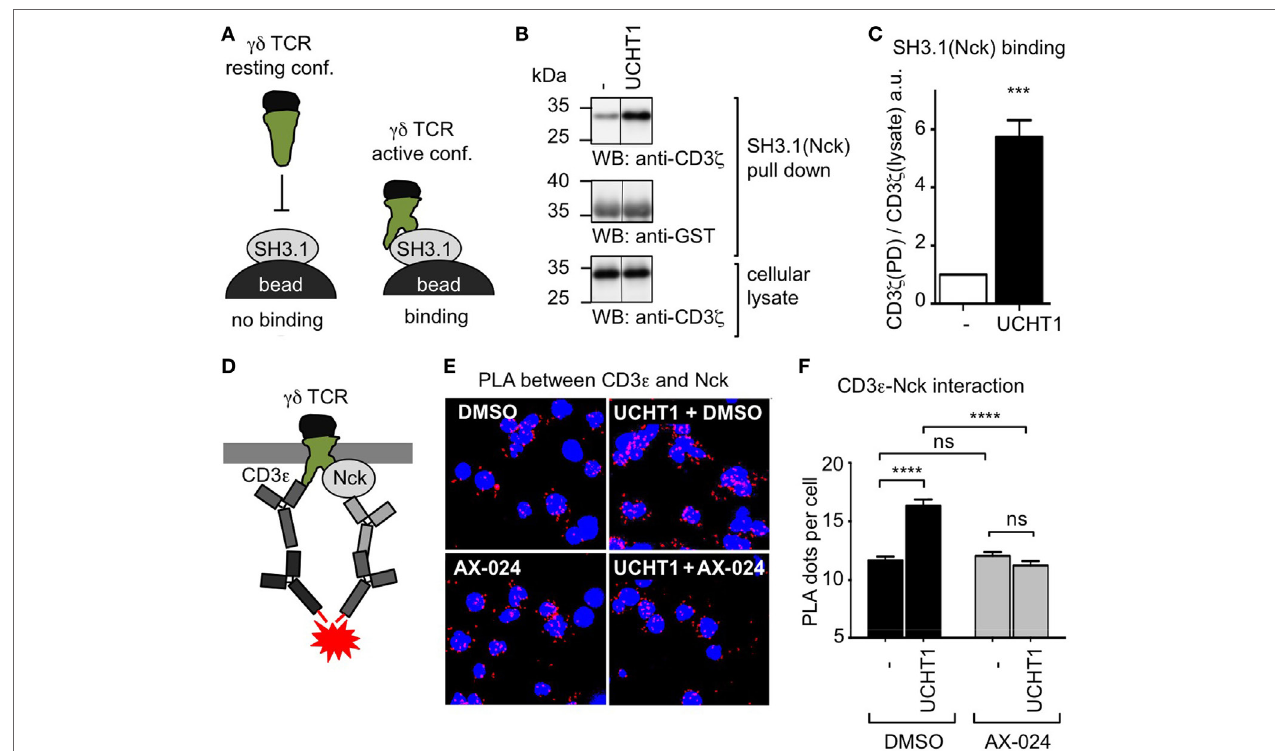
FigUre 2 | Using its SH3.1(Nck) domain Nck binds to the UCHT1-stimulated γδ T cell antigen receptor (TCR). (a) Schematic of the SH3.1(Nck) pull down assay. (B) Zoledronate-expanded γδ T cells were left untreated ( − ) or stimulated with 5 µg/ml UCHT1 at 37°C for 5 min. The cellular lysates were incubated with SH3.1(Nck)-coupled beads and bound proteins separated by SDS-PAGE along with aliquots of the cellular lysate. Western blotting was done using anti-CD3 ζ and anti-GST antibodies. (c) The normalized ratio of the band intensities of CD3 ζ to GST in the SH3.1(Nck) pull down is plotted. Data of three independent experiments were used to calculate the mean ± SD; statistics was done by two-tailed t -test. (D) Schematic of the in situ proximity ligation assay (PLA) using anti-CD3 ε and anti-Nck antibodies. (e) Close proximity between the TCR and Nck was detected by in situ PLA. Zoledronate-expanded γδ T cells were either left untreated ( − ) or treated with 5 µg/ml UCHT1 in the absence or presence of 10 nM AX-024 at 37°C for 5 min. After fixation and permeabilization, PLA was performed using the primary antibodies goat anti-CD3 ε (M20) and rabbit anti-Nck1, and the corresponding secondary antibodies. Nuclei were stained with DAPI. (F) The corresponding quantification of the red PLA dots and the mean ± SEM is displayed; statistics was done by two-tailed t -test. For each condition 500 cells were analyzed. Three independent experiments were performed ( n =